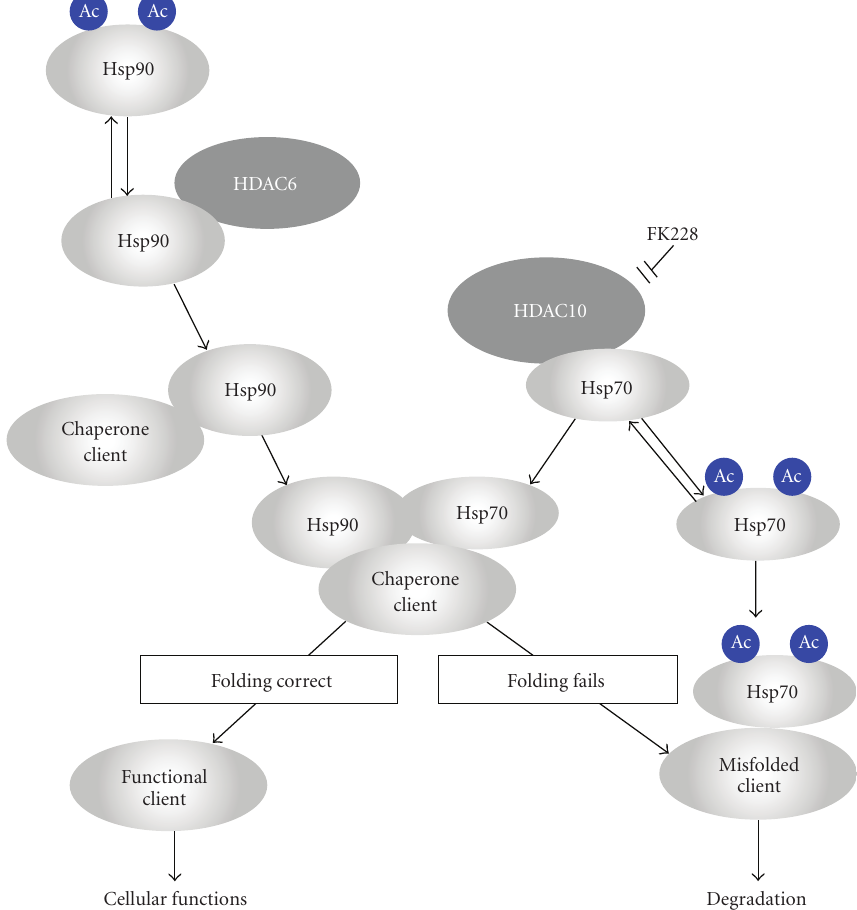
Figure 3: A model of how HDAC6/Hsp90 and HDAC10/Hsp70 collaboratively work as protein chaperones. Deacetylation of Hsp90 catalyzed by HDAC6 might prime its chaperone function. Deacetylated Hsp70, catalyzed by HDAC10 or by another deacetylase, joins the Hsp90/chaperone client complexes to help with correct folding of the clients. Acetylation of Hsp70, a likely result of HDAC10 deregulation, might cause incorrect folding of proteins or facilitate the subsequent degradation of misfolded